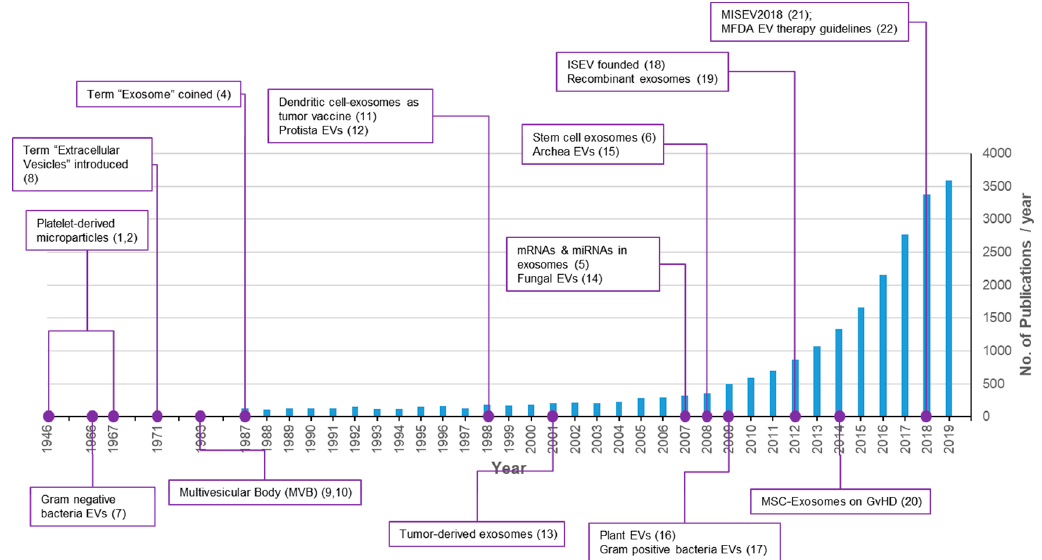
Figure 1. Trends of publications and major discoveries regarding exosomes. The number of publications was retrieved with a PubMed search using the keywords exosomes, exosome, extracellular vesicles, extracellular vesicle, and platelet-derived particles on 17 October 2019.